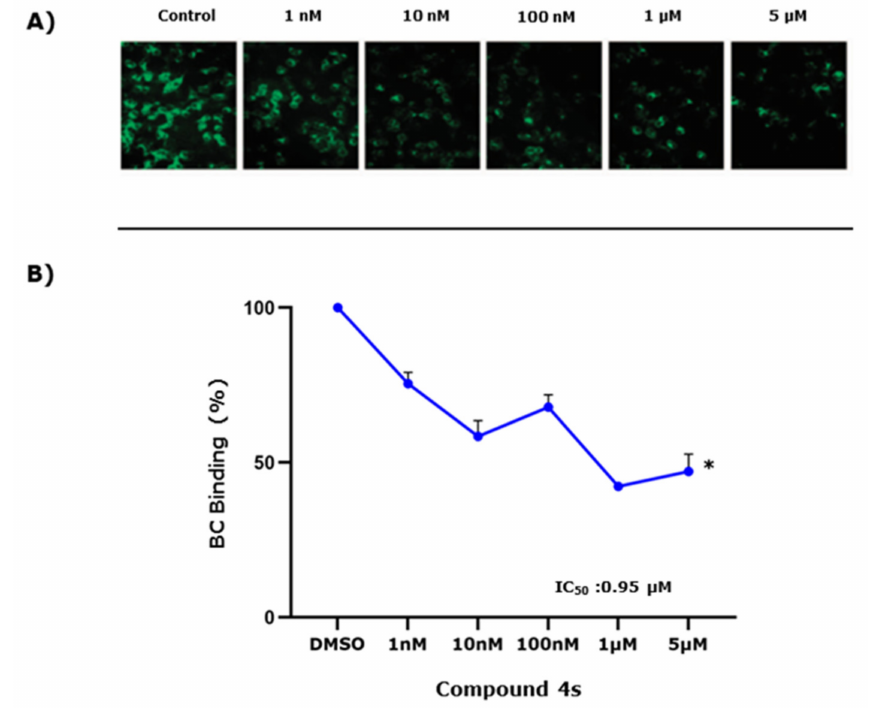
Figure 5. Binding of 4s to HEK293T cells incubated with the fluorescent compound BC in a competi- tion assay. ( A ) Fluorescence photomicrographs of the competitive binding of BC (green) to HEK293T cells treated with increasing concentrations of 4s or BODIPY only (control). ( B ) The concentration– response curve shows the percentage of BC binding to WT SMO after treatment with compound 4s . IC 50 for binding to WT SMO = 0.95 µ M. Data indicate the average ± SD of three separate experiments. (*) p < 0.05 vs. control. Data are the average BC intensity of five fluorescence microscopy